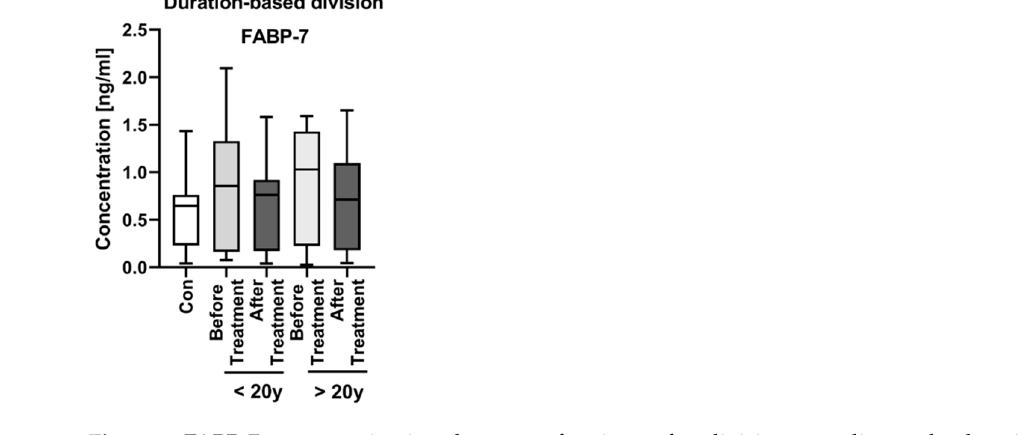
Figure 3. FABP-7 concentration in subgroups of patients after division according to the duration of the dermatosis–less or more than 20 years, with division before and after the treatment.